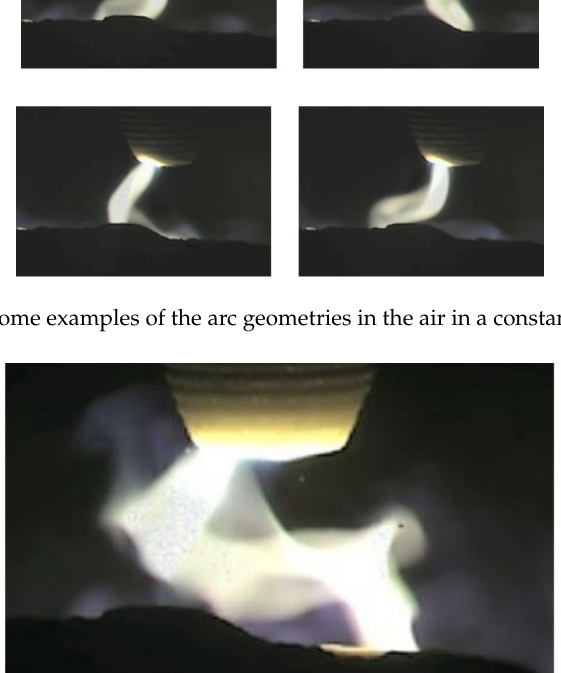
Figure 7. Example of the chaotic movement of the arc due to the increase in the arc current [20].